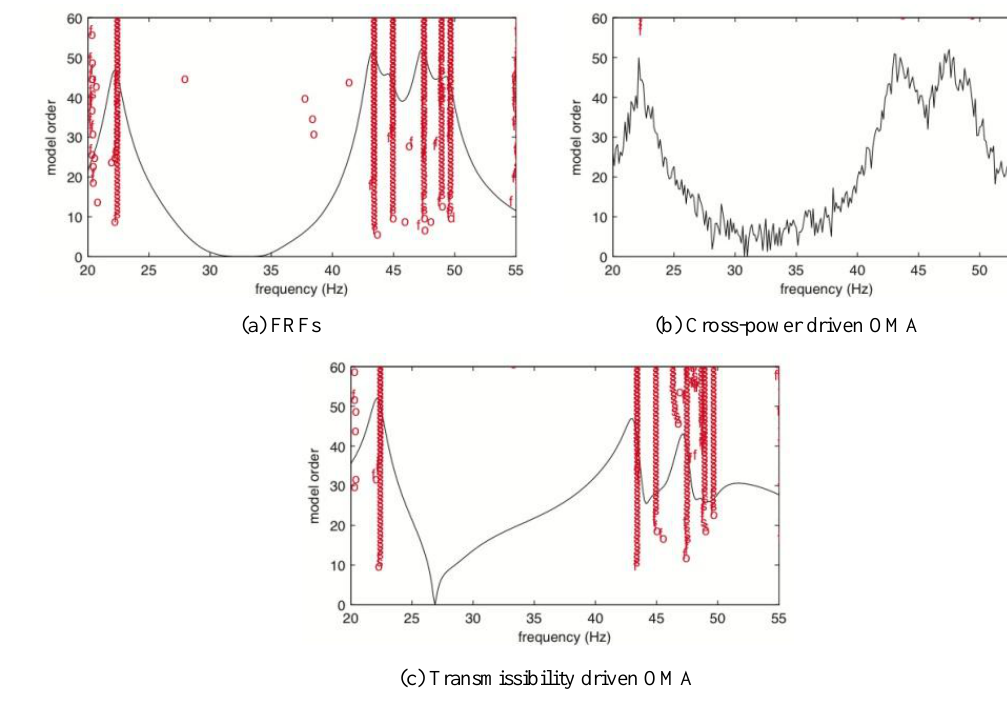
Fig. 9. Stabilisation diagram for loading cases 1 and 2.